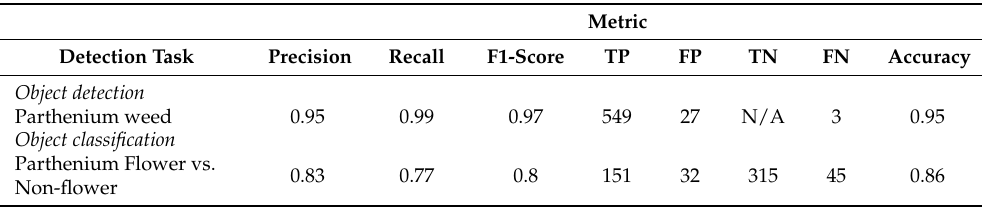
Figure 11. Confusion matrix depicting predicted flowering/non-flowering class numbers vs. true flowering/non-flowering class numbers. The resulting performance metrics are indicated in Table 3. Table 3. Performance metrics of the Yolov4 algorithm as a parthenium weed detector and as a classifier of the weed into flowering vs. non-flowering